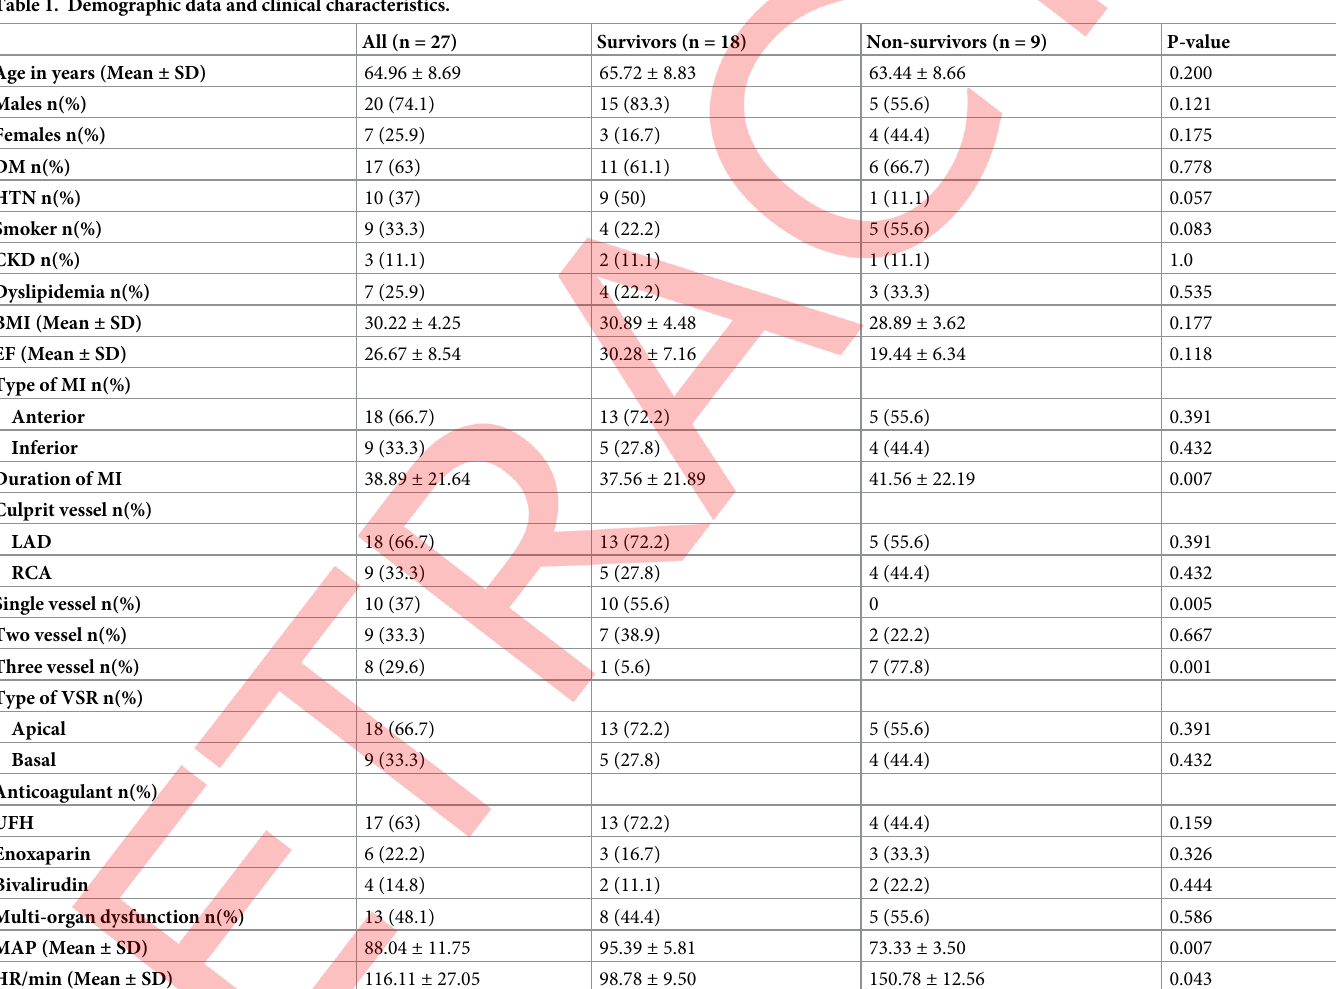
Table 1. Demographic data and clinical